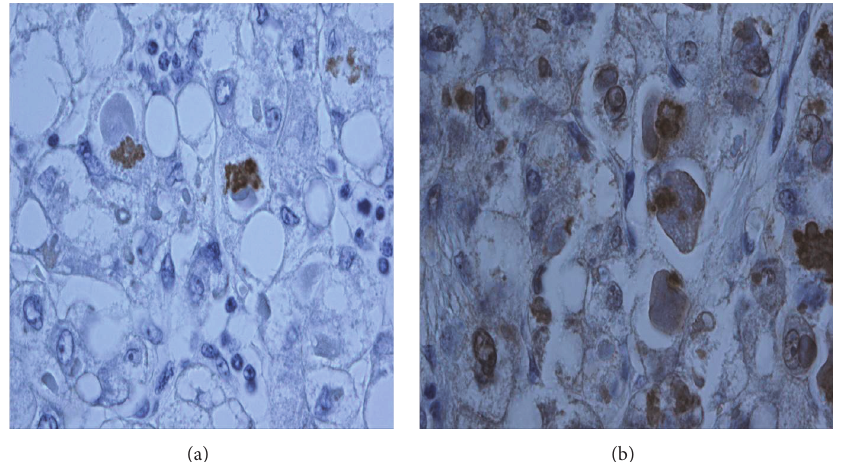
Figure 4: (a) The inclusions demonstrate focal ubiquitin expression by immunohistochemistry. (b) The cytoplasmic inclusions are positive for p62